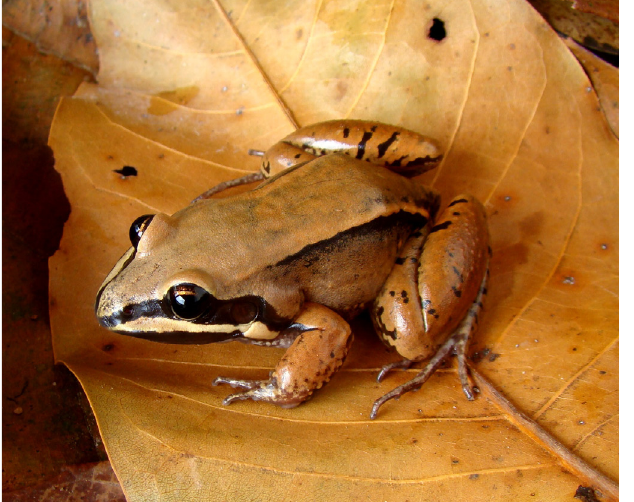
Geographic distribution